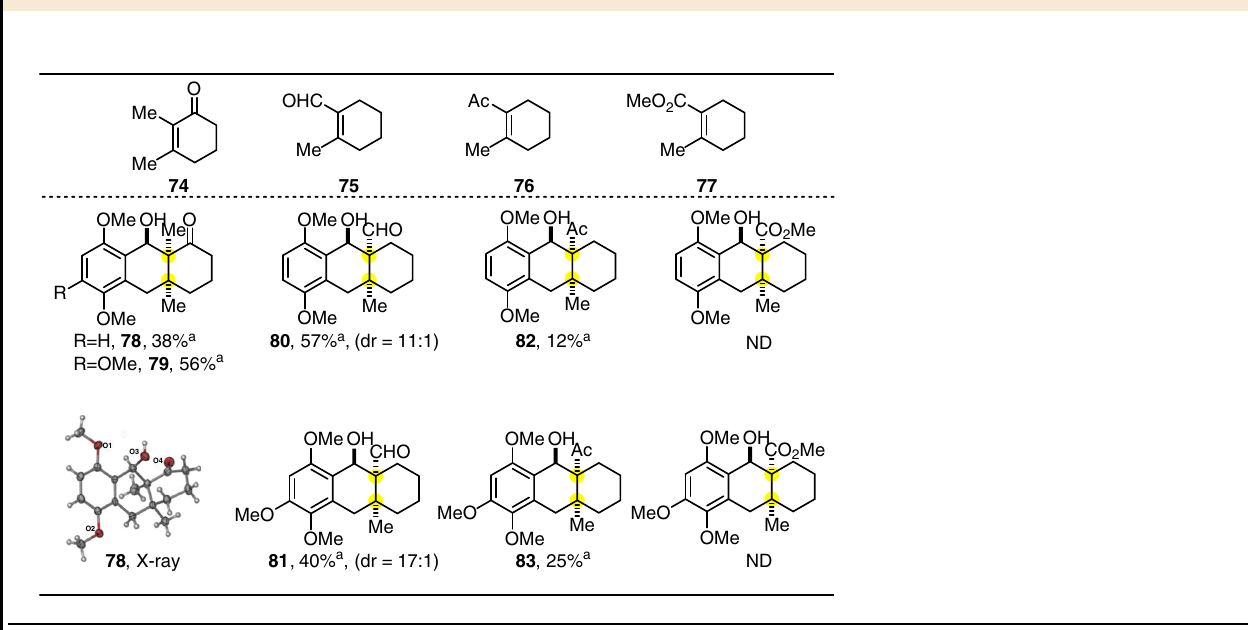
Table 4 Scope of the PEDA reaction involving 1,1,2,2-tetrasubstituted ole fi ns as